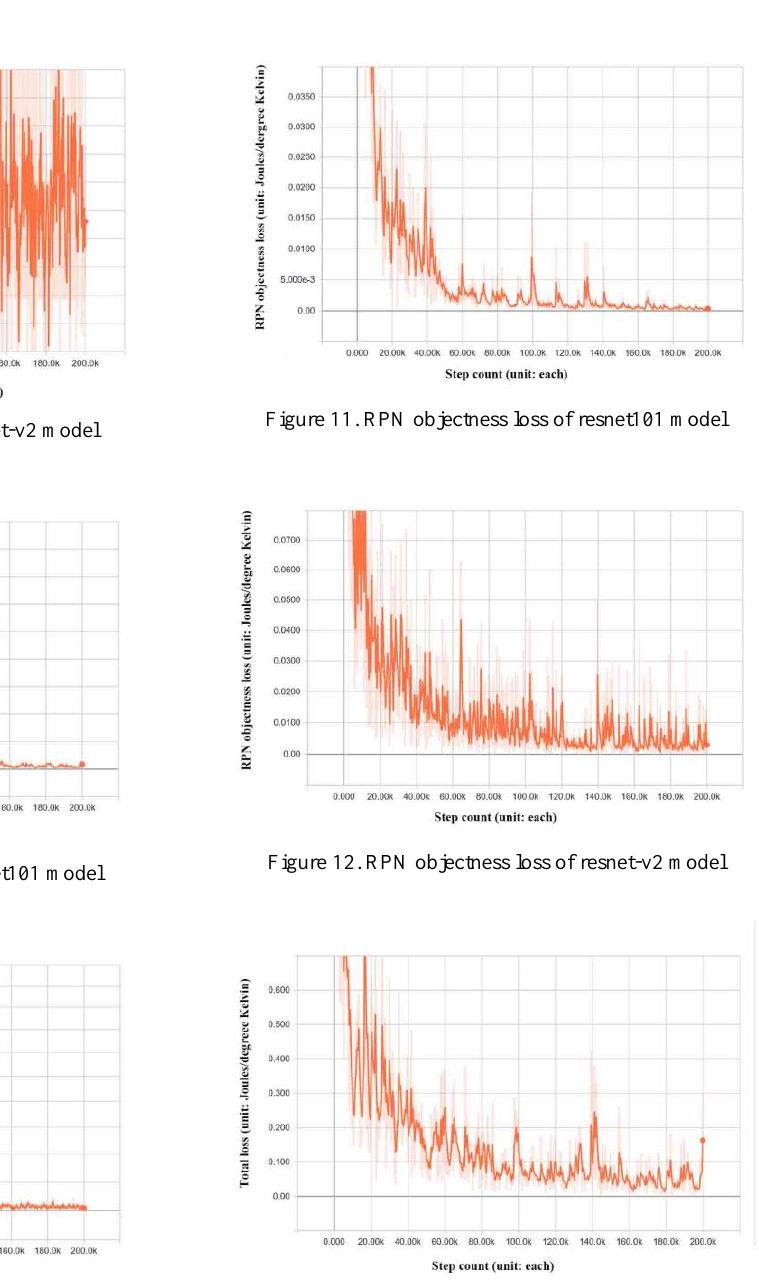
Figure 13. Total loss of resnet101